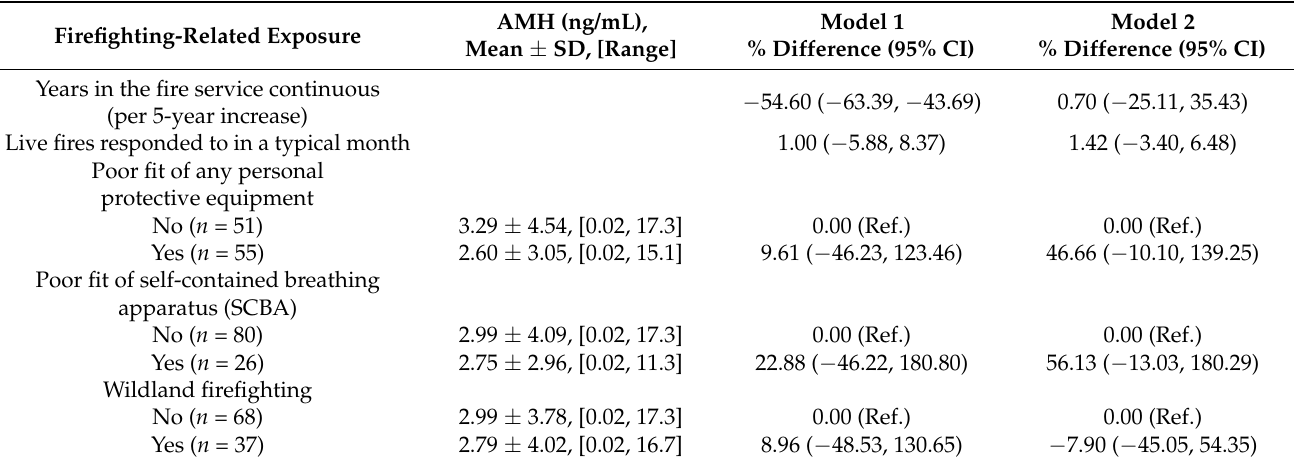
Table 4. Among firefighters, occupational exposures and percent change in anti-müllerian hormone ( n =